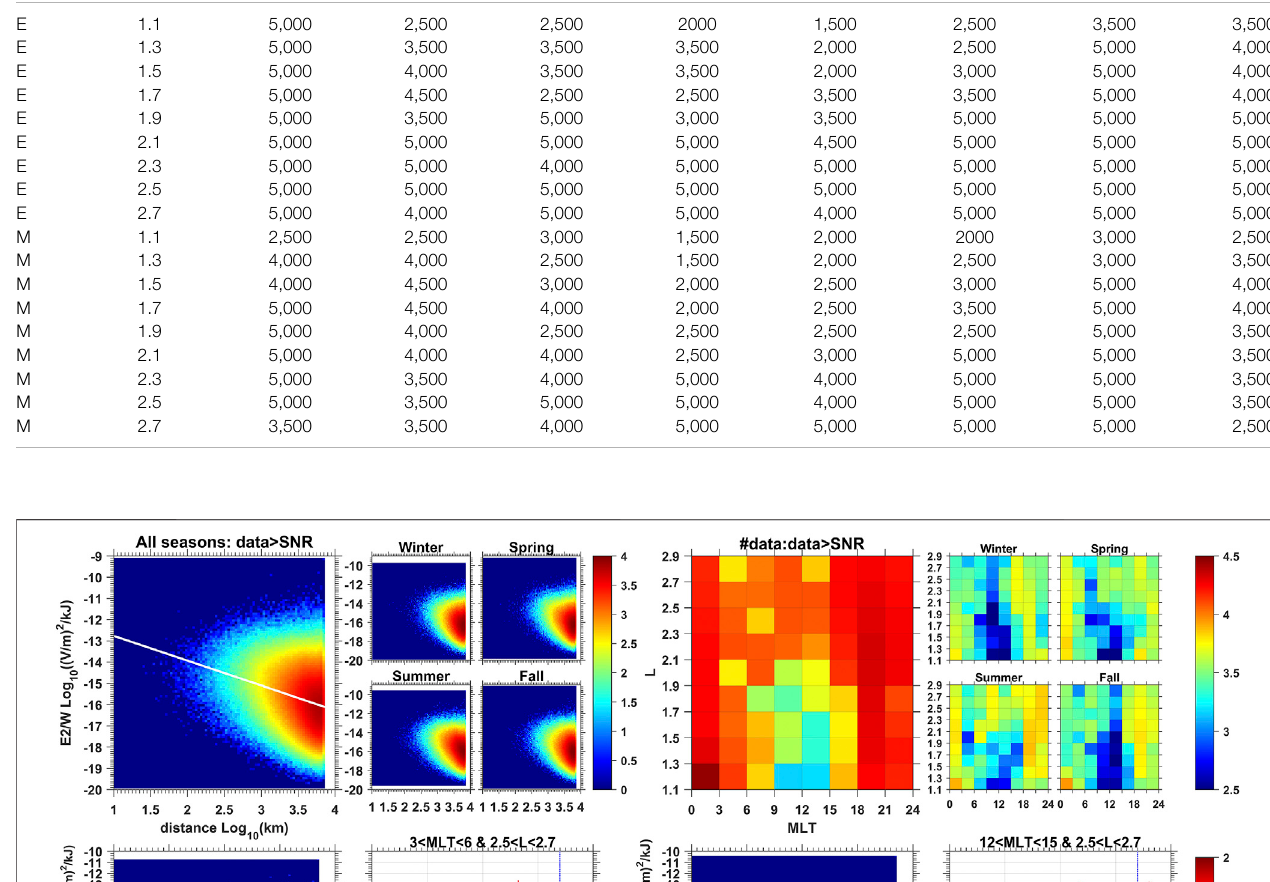
TABLE 1 | Maximal distance, d max (in km) used for fi tting the (M) magnetic power distribution and the (E) electric power distribution for a given L-MLT bin (for all seasons). L\MLT